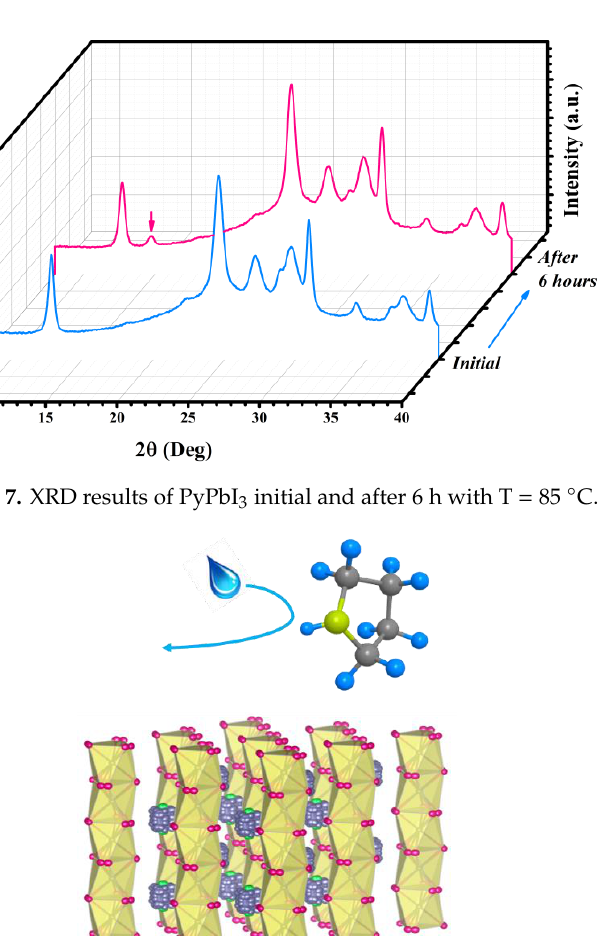
Figure 7. XRD results of PyPbI 3 initial and after 6 hours with T = 85 °C.